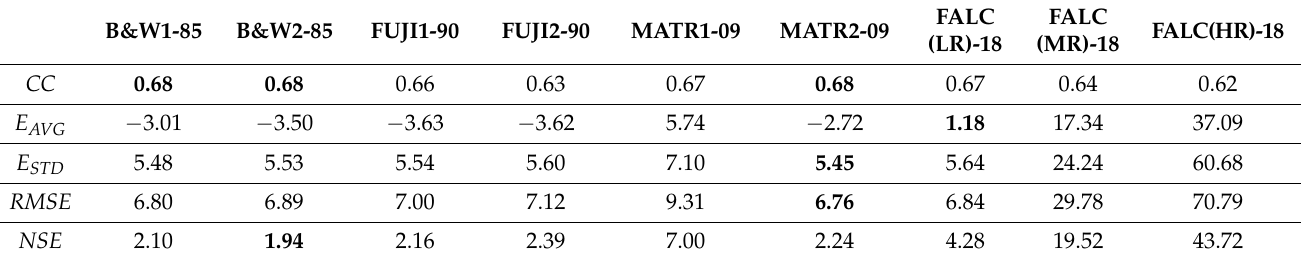
Table 6. Error scores for the various radar algorithms listed in Table 5. CC , E AVG , E STD , RMSE and NSE stand for the correlation coefficient, the average error (mm · h − 1 ), the error standard deviation (mm · h − 1 ), the root mean square error ( RMSE ) and the normalized standard error ( NSE ), respectively.